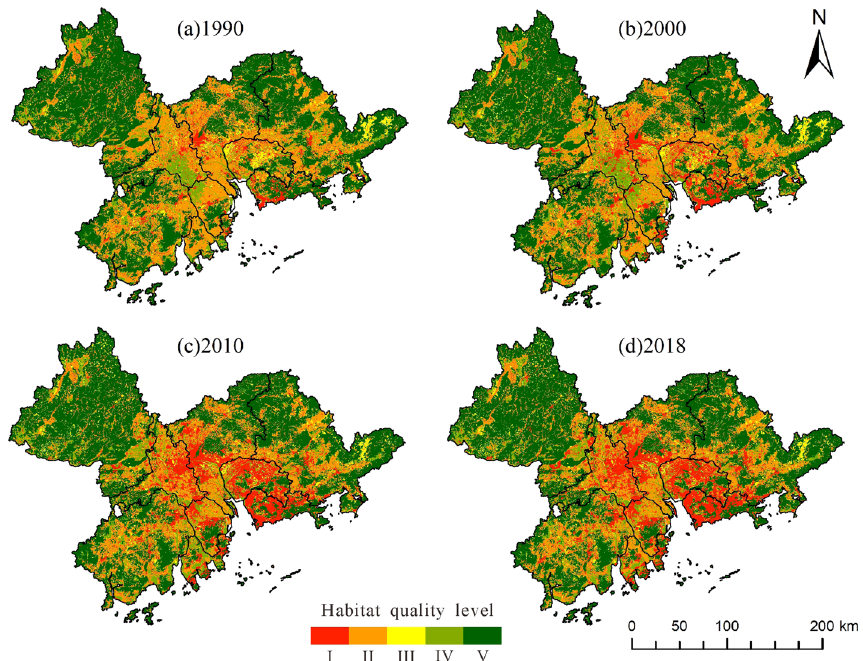
Figure 5. Spatial and temporal variation in habitat quality